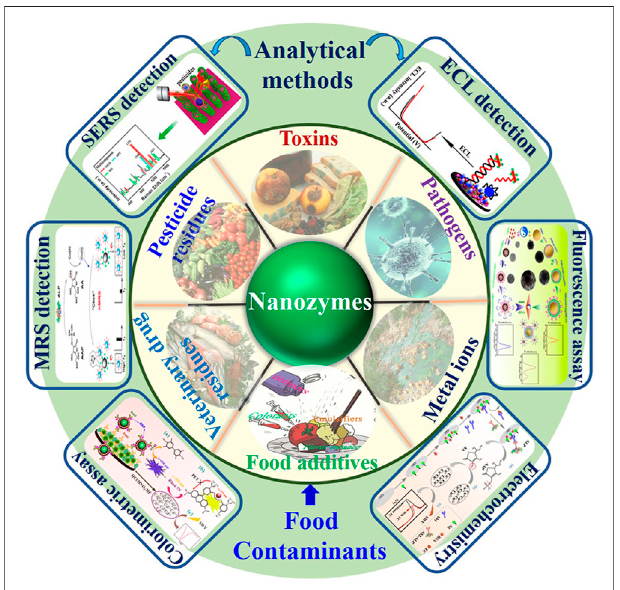
FIGURE 1 | The schematic presentation of nanozymes-based analytical techniques for the detection of different food contaminants (MRS, magnetic relaxing sensing; SERS, surface enhanced Raman scattering; ECL, electrochemiluminescence).